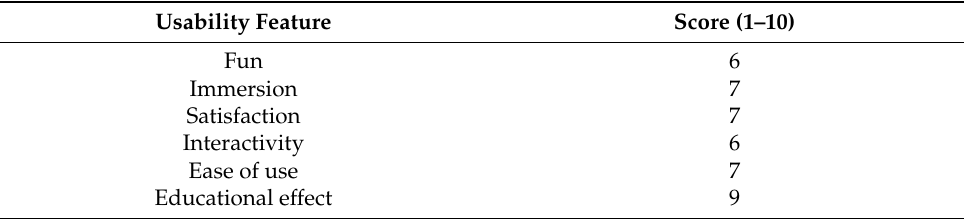
Table 3. Average of usability evaluation on the Melting Sea Ice